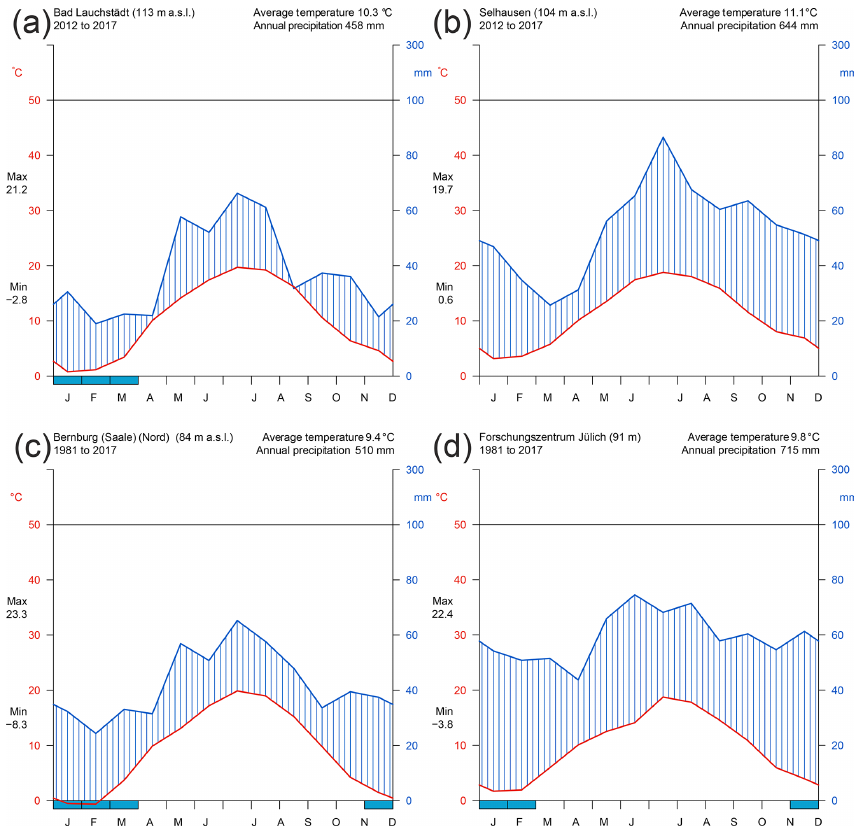
Figure 1. Climate diagrams according to Walter and Lieth (1967) for Bad Lauchstädt (a) and Selhausen (b) for 2012 to 2017 and Bernburg (Saale) (Nord) (c) and Forschungszentrum Jülich (d) for 1981 to 2017. Data were obtained from the SOILCan weather stations at Selhausen and a climate station at Bad Lauchstädt above sea level. The long-term weather data were taken from the weather stations of the Deutscher Wetterdienst (Germany’s national meteorological service) at Bernburg (Saale) (Nord) and the Forschungszentrum Jülich. The blue bars at the bottom of subplot (a, c, d)) indicate months where frost is likely to